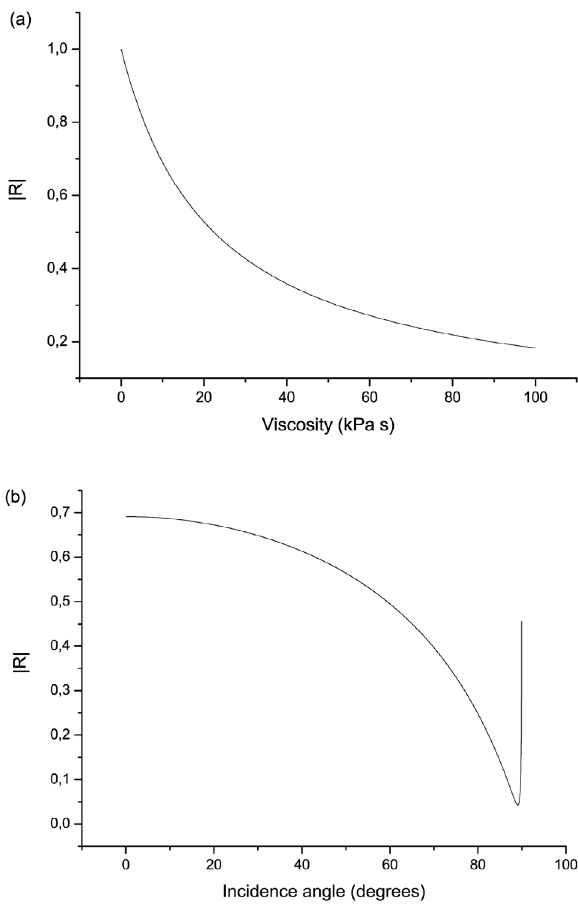
Figure 2. Absolute value of the reflection coefficient of SH waves as a function of viscosity (a) (normal incidence, i.e., i = 0) and in- cidence angle (b) (for h ' = 10 kPa s). The frequency is f and the fracture thickness is 1 cm.